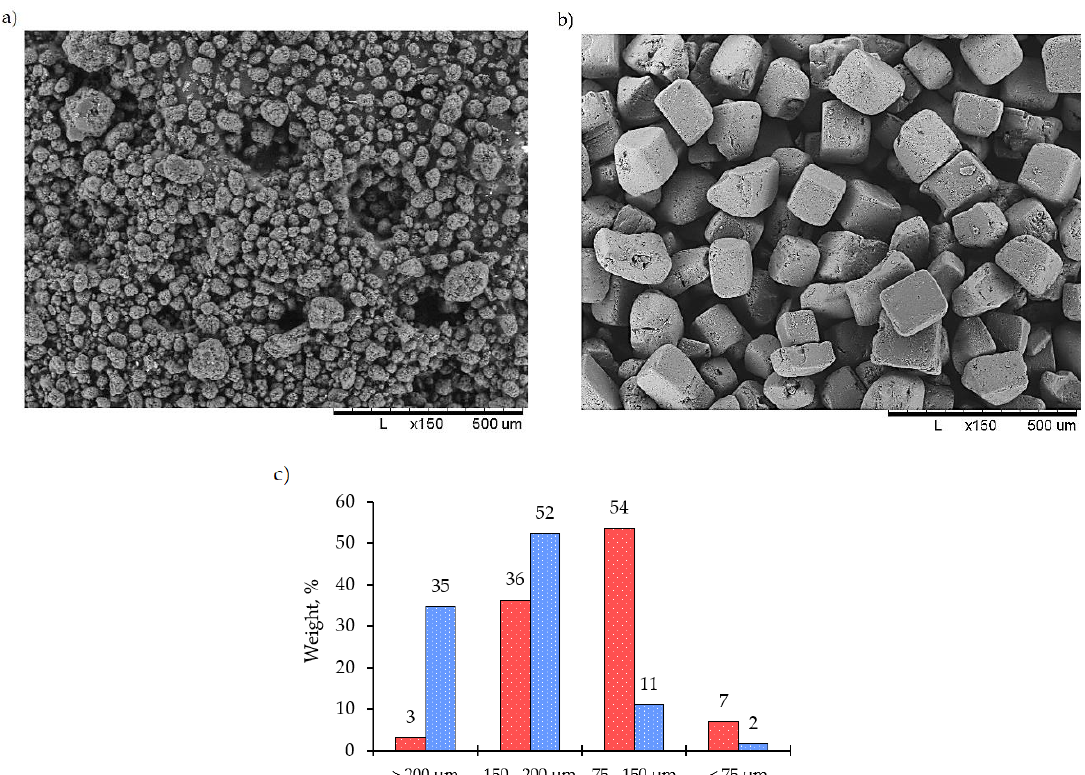
Figure 1. The appearance of the as-supplied powders of ( a ) ultra-high molecular weight polyethylene (UHMWPE); ( b ) rock salt; ( c ) The histogram of particle size distribution after sieving. Red bars — UHMWPE, blue bars — salt.